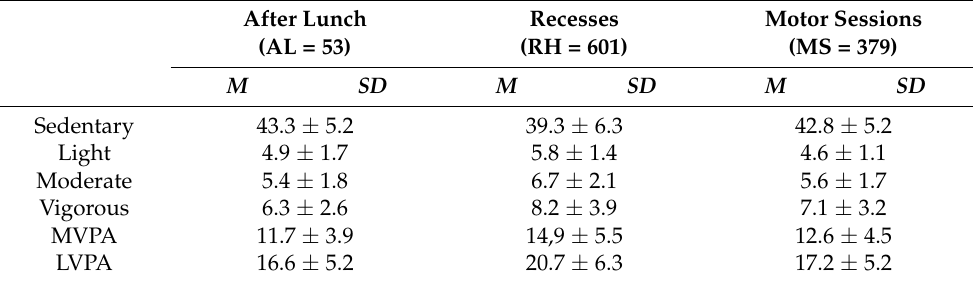
Table 7. PA performed during free time after lunch, recess and specific motor sessions.